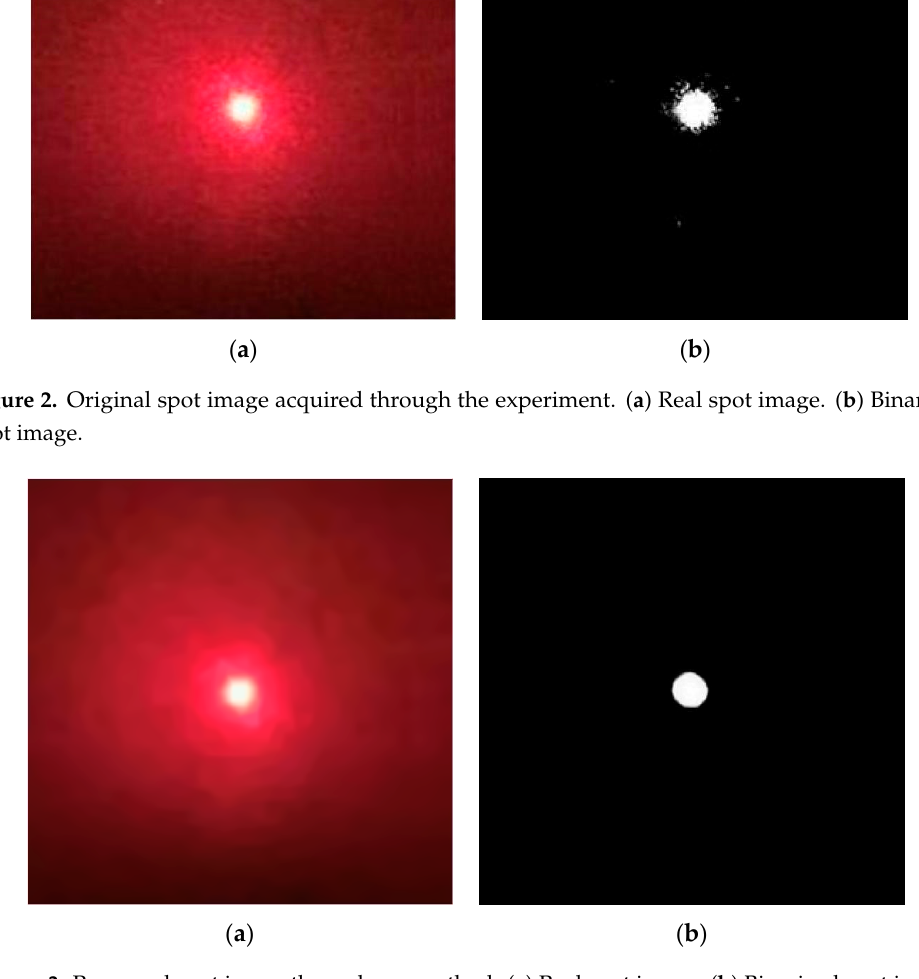
Figure 3. Processed spot image through our method. ( a ) Real spot image. ( b ) Binarized spot image.